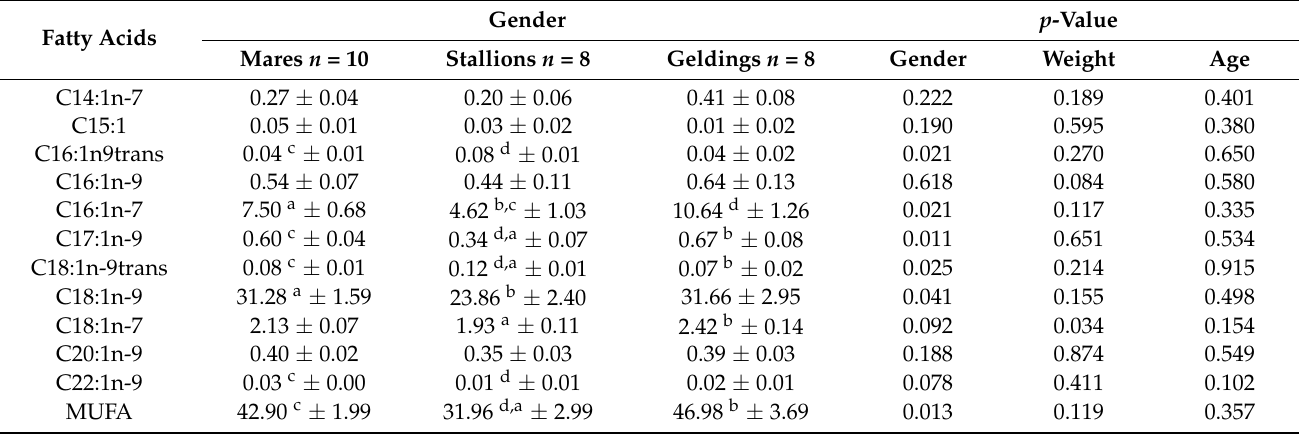
Table 7. Effects of gender, age, and carcass weight on monounsaturated fatty acid (% of total FA) composition of horse meat